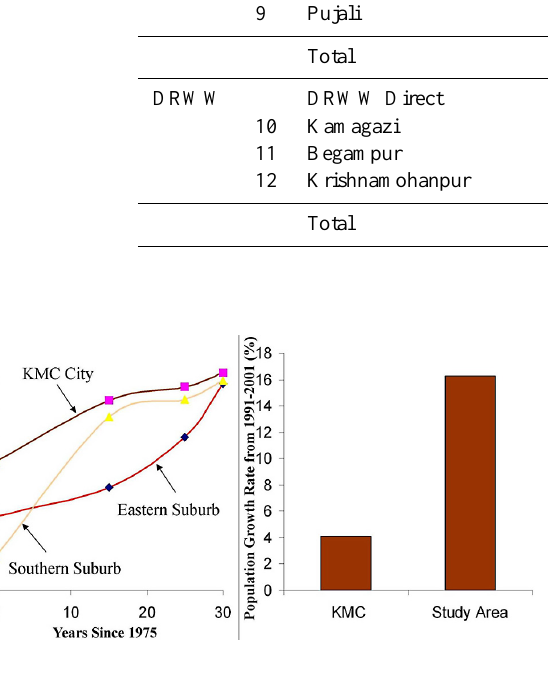
Figure 2. Urban growths in fringes of